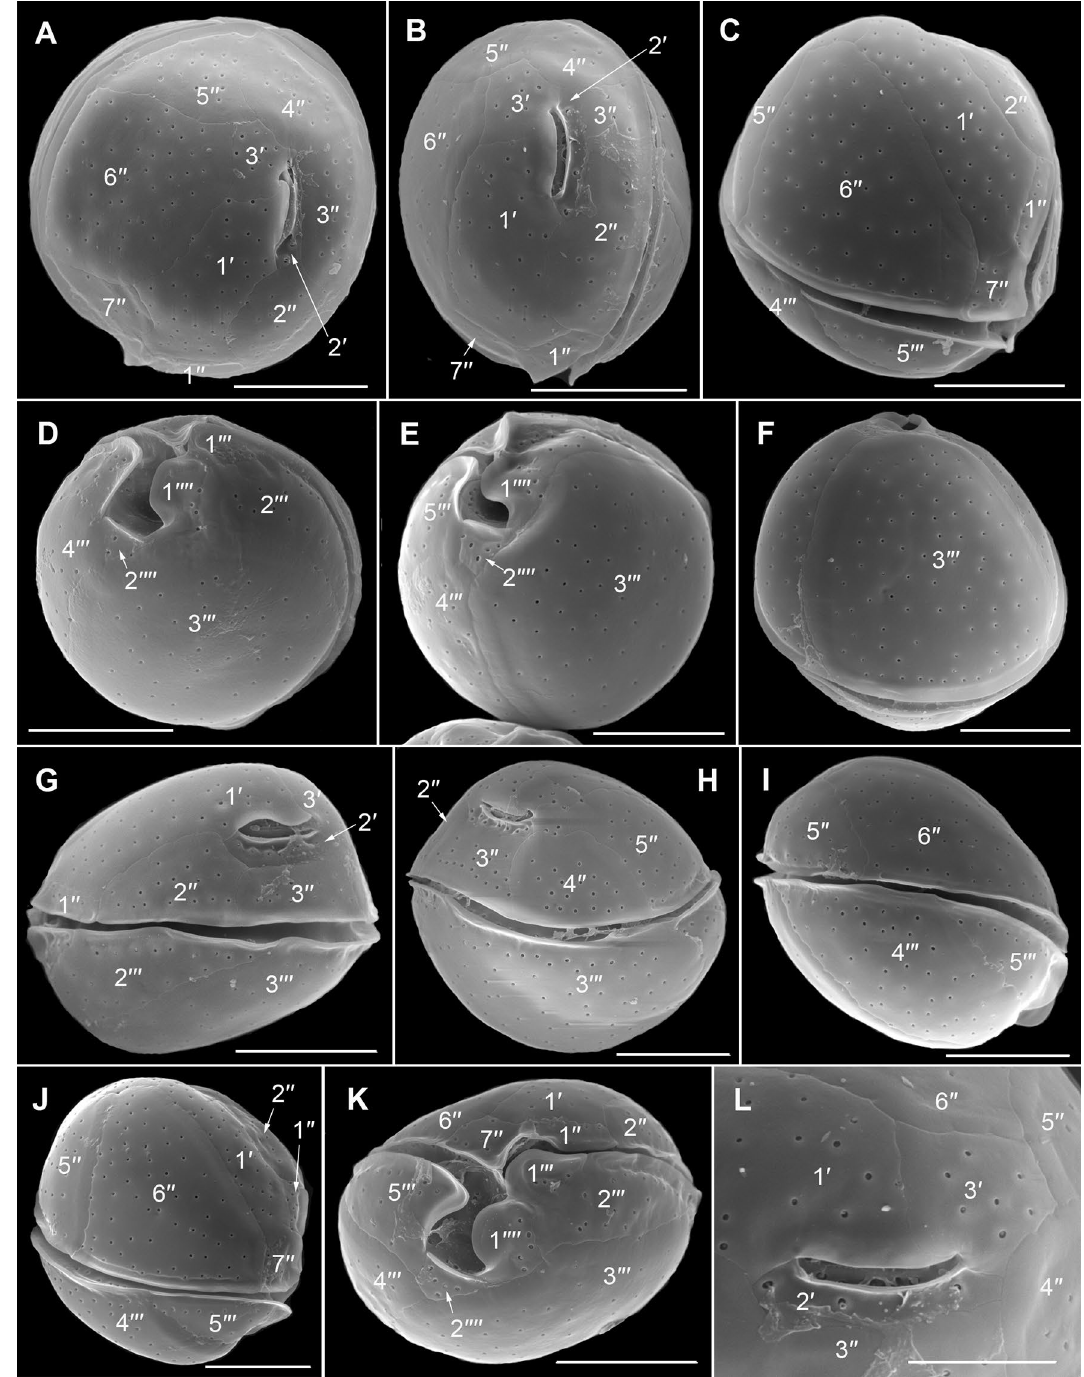
Figure. 10. Scanning electron micrographs of Coolia malayensis strain C6C1 showing the thecal tabulation. ( A ) Epitheca in apical view. ( B ) Epitheca in apical to left lateral view. ( C ) Ventral to right lateral view. ( D,E ) Hypotheca in antapical view. ( F ) Hypotheca in left lateral view. ( G ) Cell in left lateral view. ( H ) Cell in dorsal view. ( I ) Cell in right lateral view. ( J ) Cell in right lateral to ventral view. ( K ) Cell in ventral view. ( L ) Detail of the dorsal epitheca showing the slit-like apical pore complex surrounded by the apical plates (1–3 ′ ). Scale bars = 10 µm, except L: 5